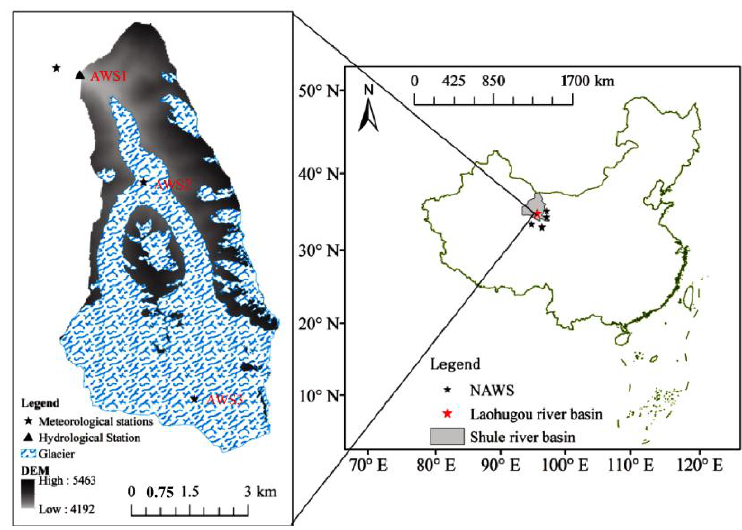
Figure 1. Map of the location of the Laohugou Glacier Basin (LHGB) and meteorological and hydrological observation sites. (NAWS is the national weather stations).